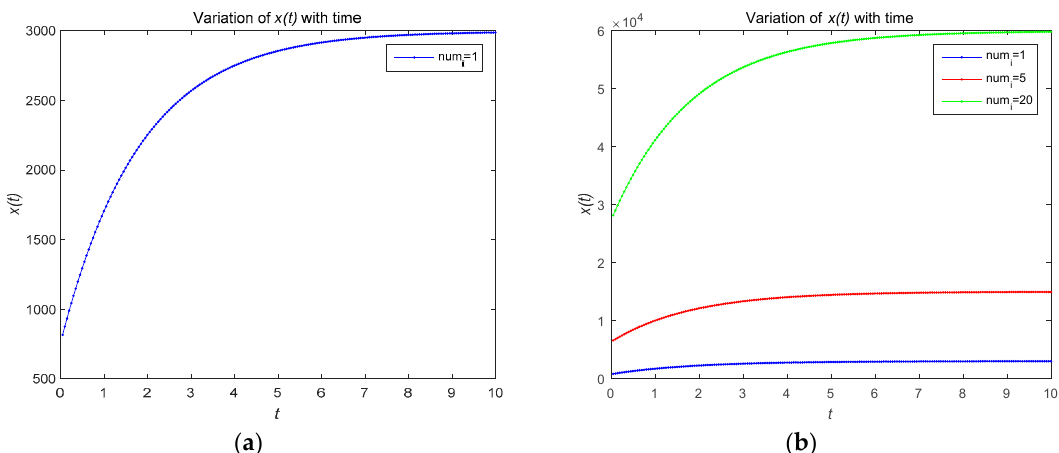
Figure 5. ( a ) Optimal strategy of the attacker; ( b ) optimal strategy of the defender.